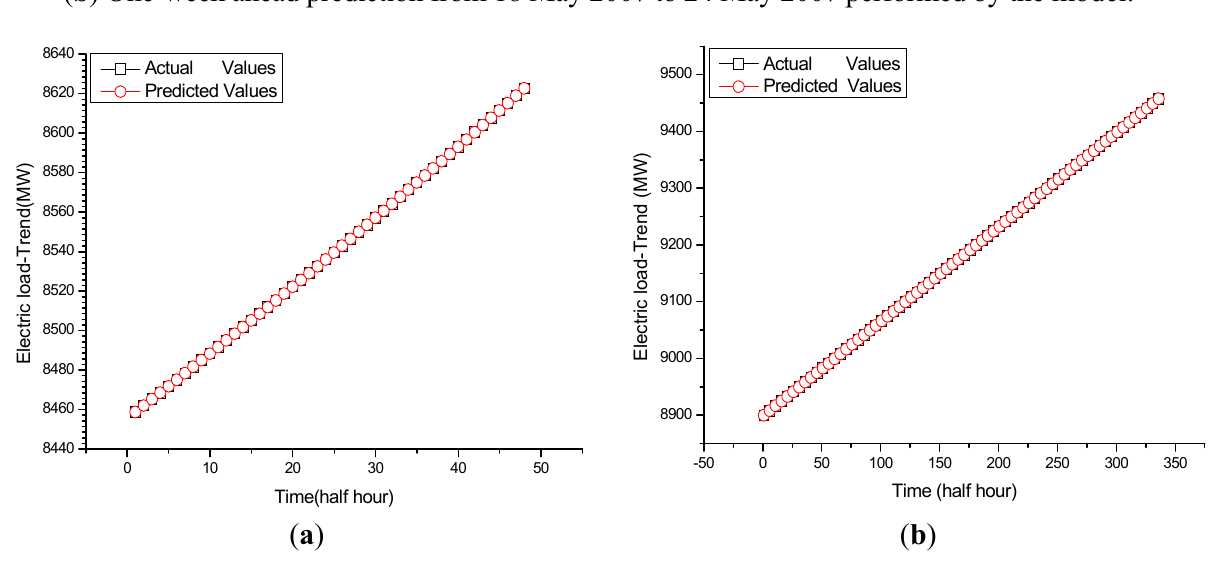
Figure 6. Comparison of the data-II and the forecasted electric load by the AR model for the two experiments: ( a ) One-day ahead prediction of 8 May 2007 performed by the model; ( b ) One-week ahead prediction from 18 May 2007 to 24 May 2007 performed by the model.